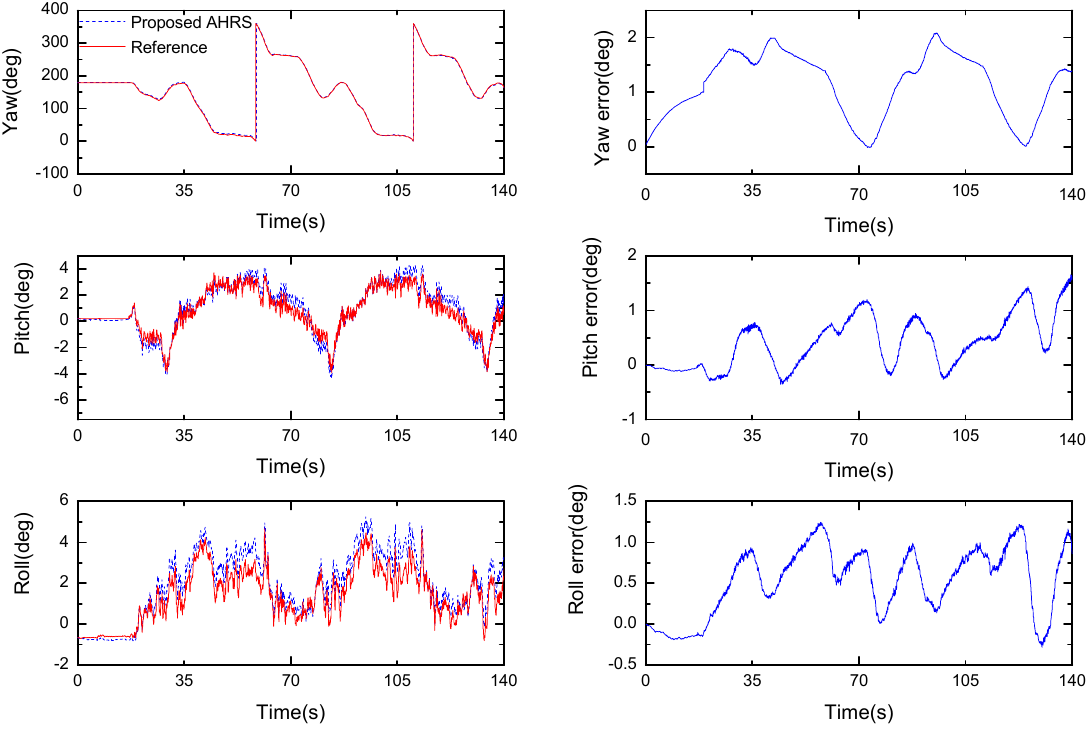
Figure 14. Orientation estimate produced by the proposed algorithm ( left , µ a = 0.001) and the difference between the estimate and reference ( right ).